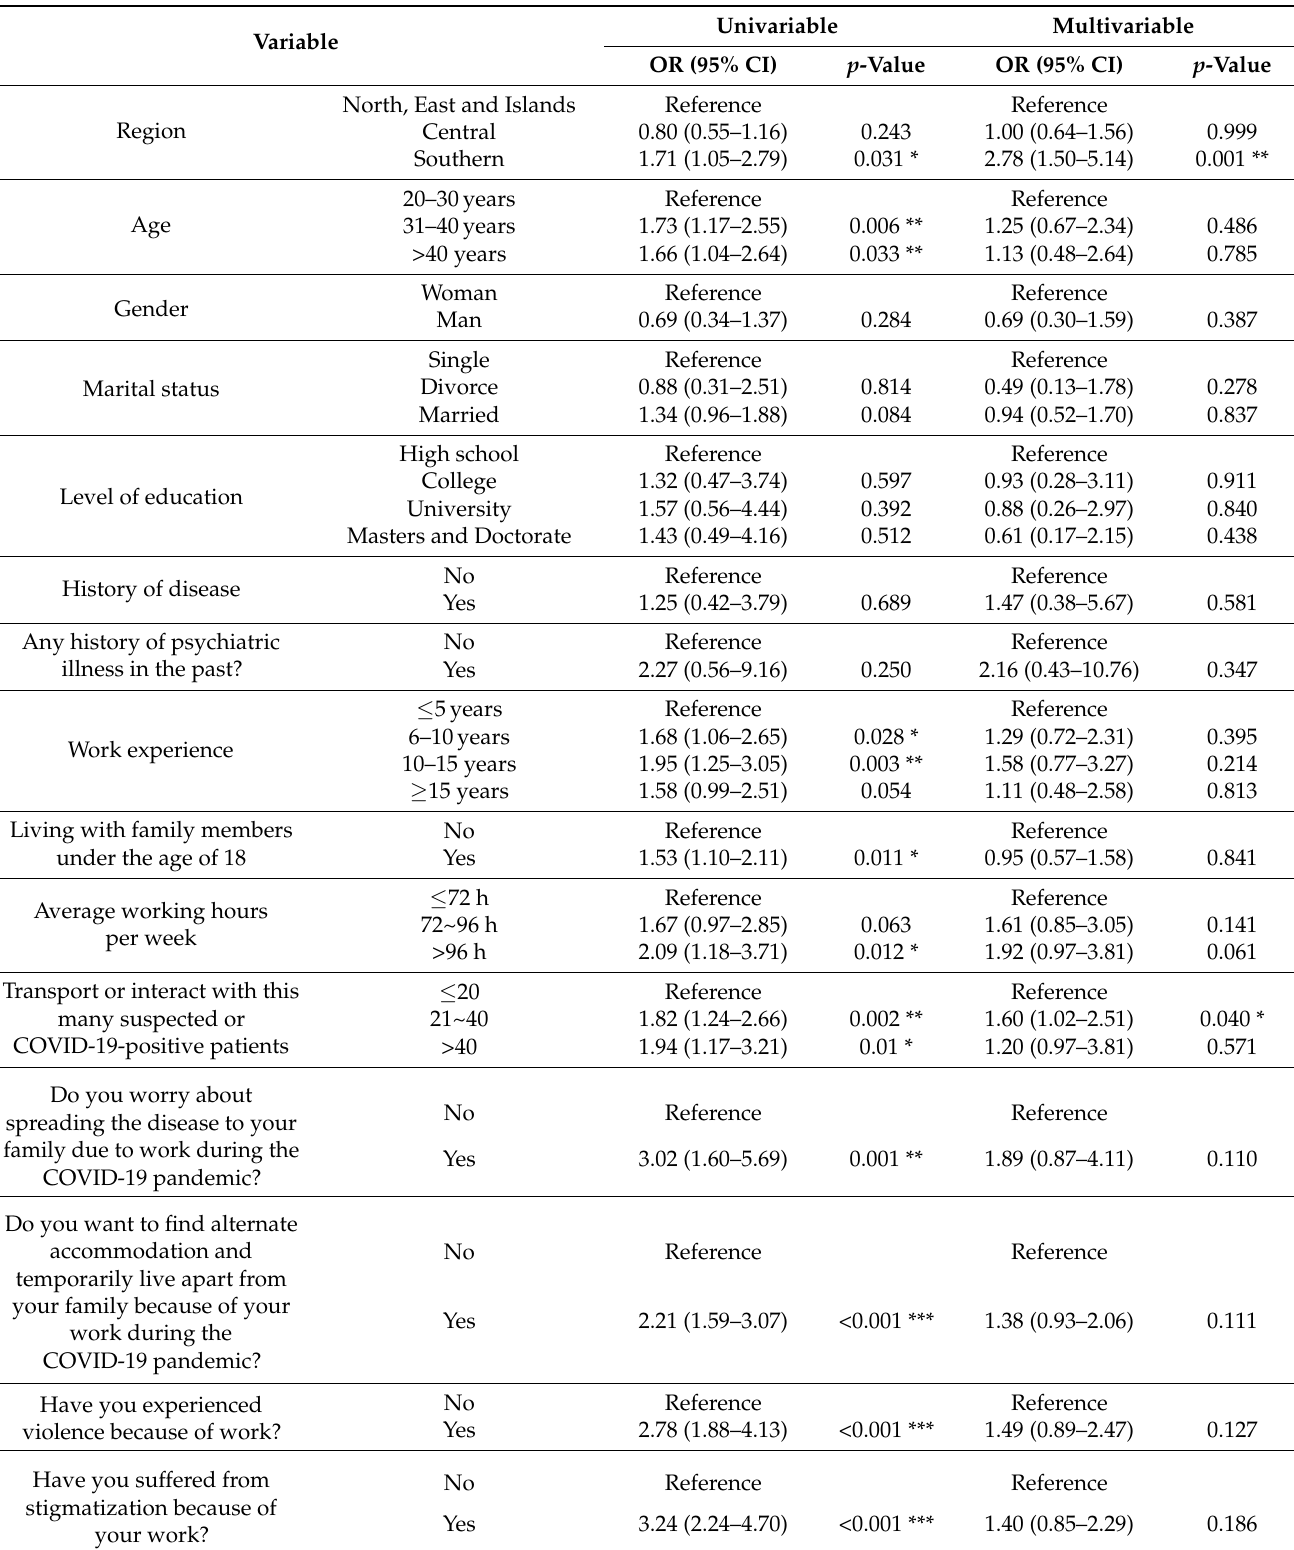
Table 5. Stress odds